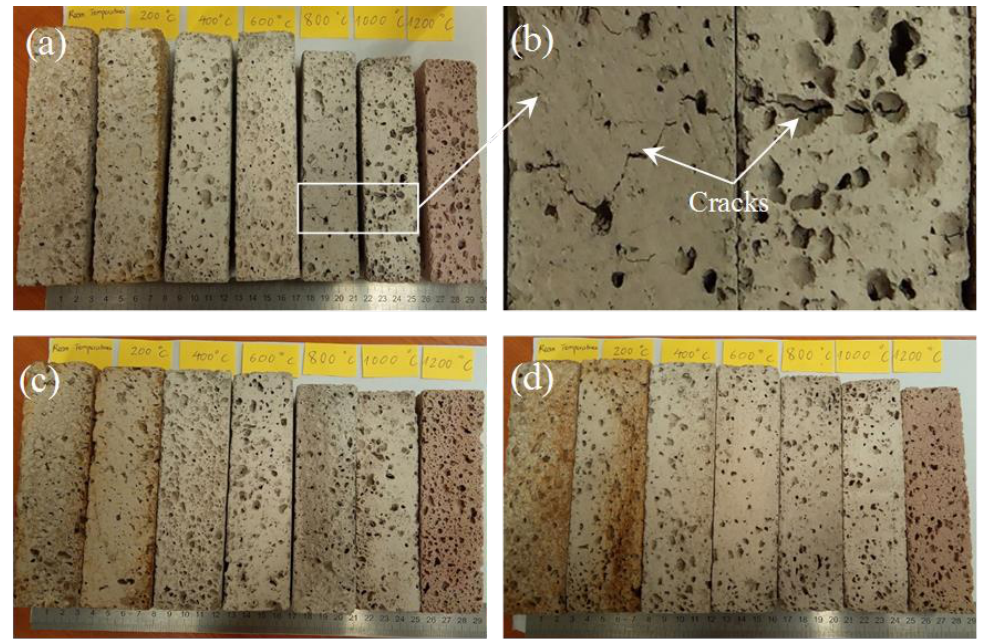
Figure 6. Photographs illustrating structural morphologies of different BGF samples after heat treatment at elevated temperatures: ( a ) and ( b ) S1, ( c ) S2, and ( d ) S3.